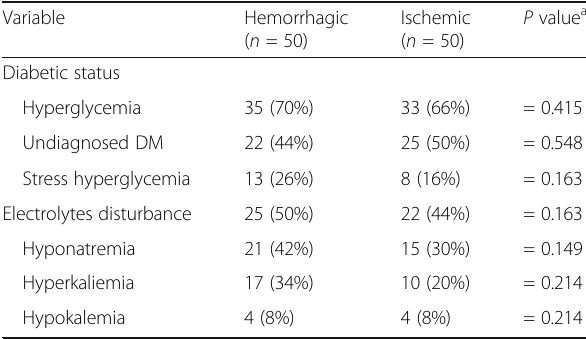
Table 2 Laboratory data differences between types of stroke Variable Hemorrhagic